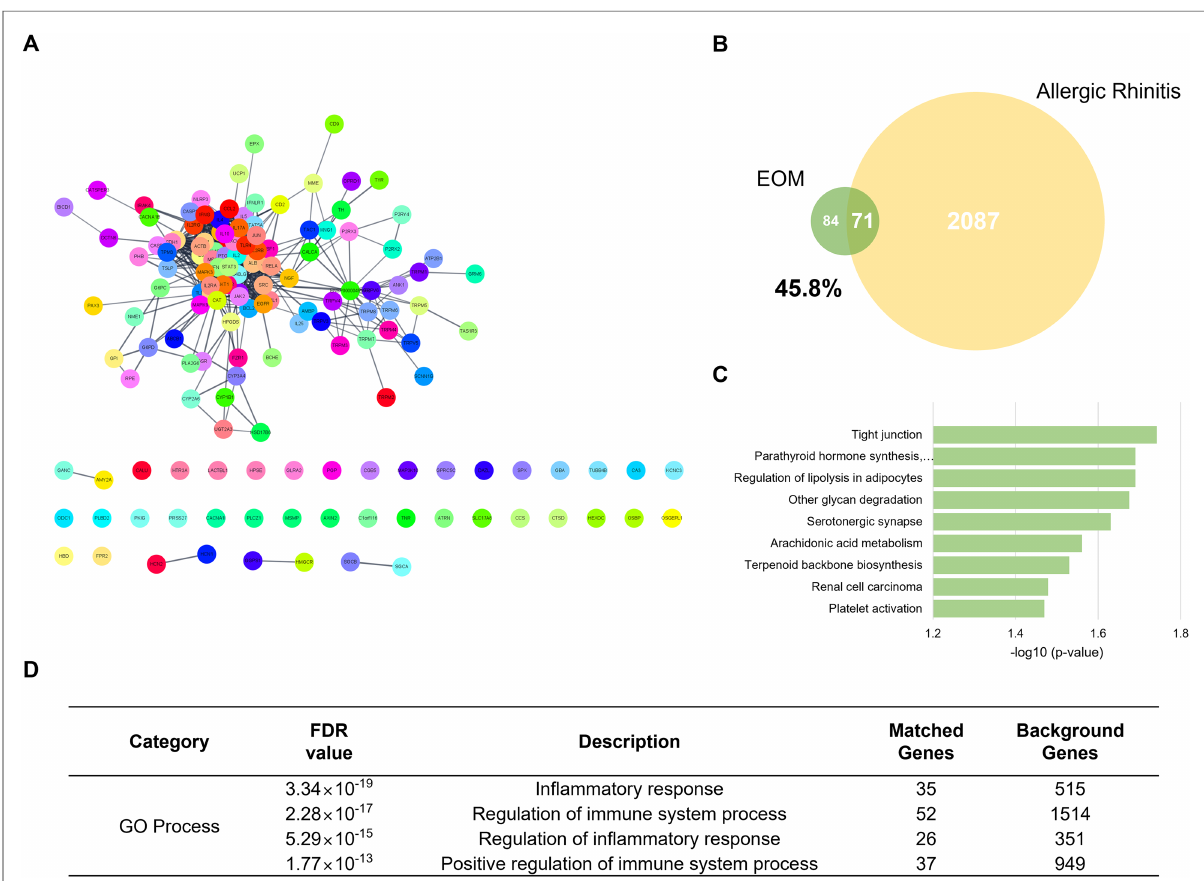
FIGURE 1 Network analysis of EOM. The PPI network of EOM Network. 150 nodes and 740 edges ( A ). The venn diagram of genes related to EOM and allergic rhinitis ( B ). Enrichment analysis of EOM network based on KEGG 2021 pathways, bar graph ( C ). Enrichment analysis of EOM network based on GO process ( D ). EOM, essential oils from the Mentha piperita leaf ; KEGG, kyoto encyclopedia of genes and genomes; GO, gene